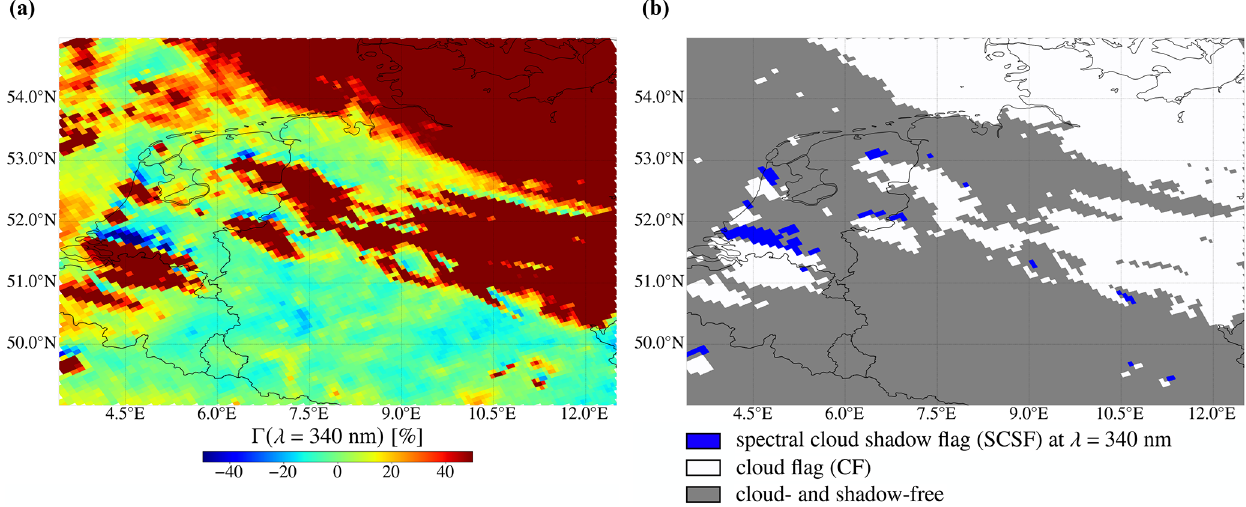
Figure 12. SCNLER–DLER contrast parameter (cid:48) at λ = 340nm measured by TROPOMI (a) and TROPOMI Level 2 UVIS ground pixels with raised SCSFs at λ = 340nm (b) , for the Netherlands and Germany on 18 November 2018. In (b) , white pixels are cloud pixels, and grey pixels do not contain a raised cloud or shadow